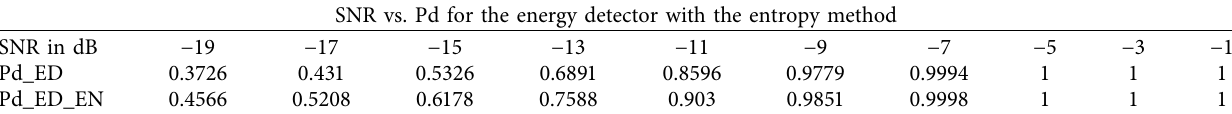
Table 3: SNR vs. P d for both the conventional and proposed technique.